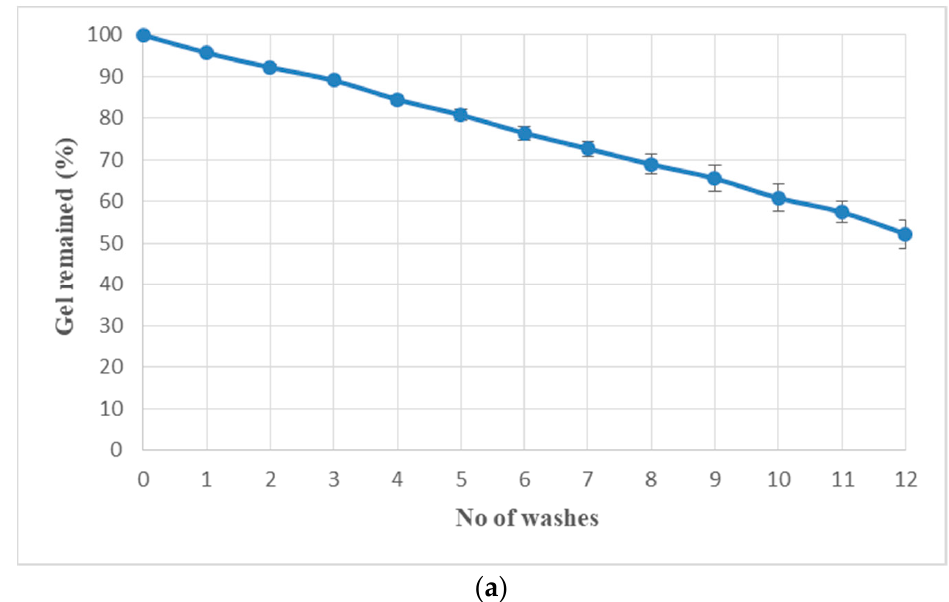
Figure 7. ( a ) Washability and ( b ) gel erosion pattern of P407 gel formulation in phosphate